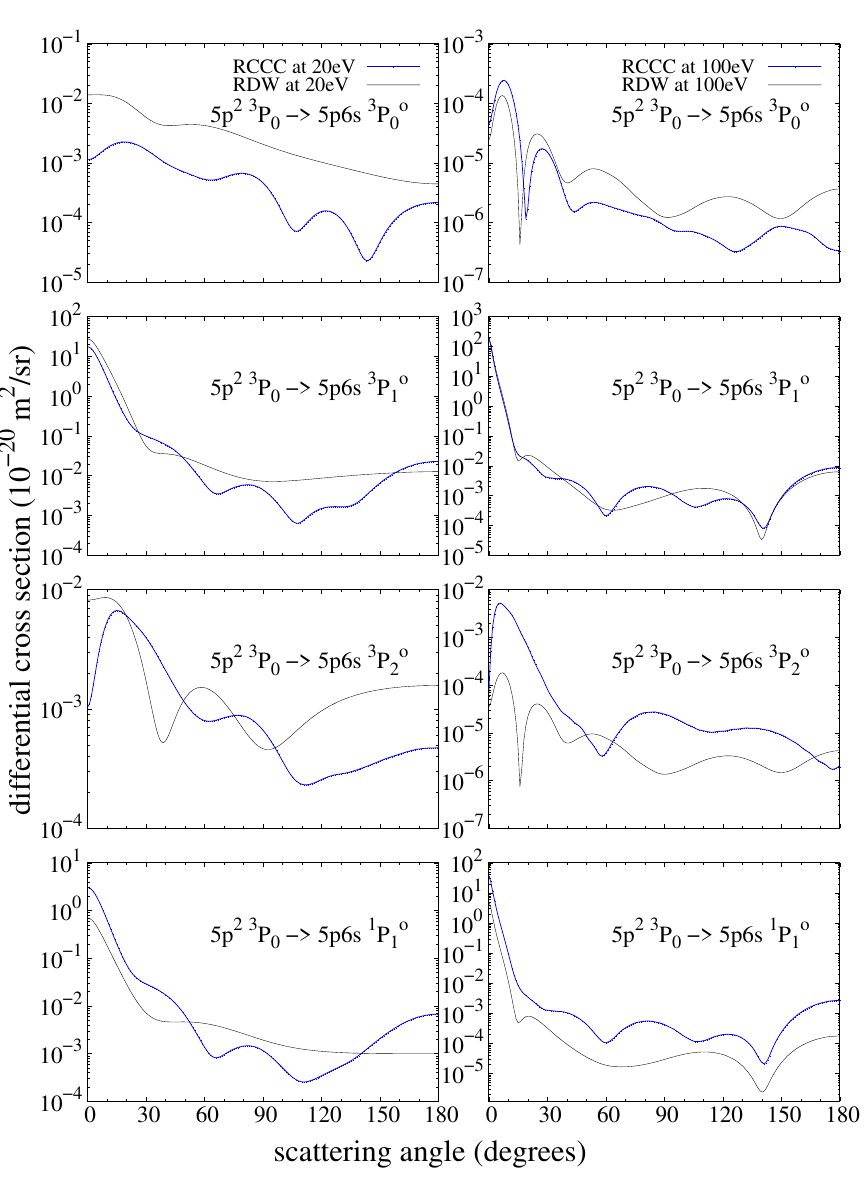
Figure 11. RCCC differential cross-sections for excitation to the 5 p 6 s manifold from the ground state at projectile energies of 20 and 100 eV. Comparison with the RDW results by Sharma et al. [8] is